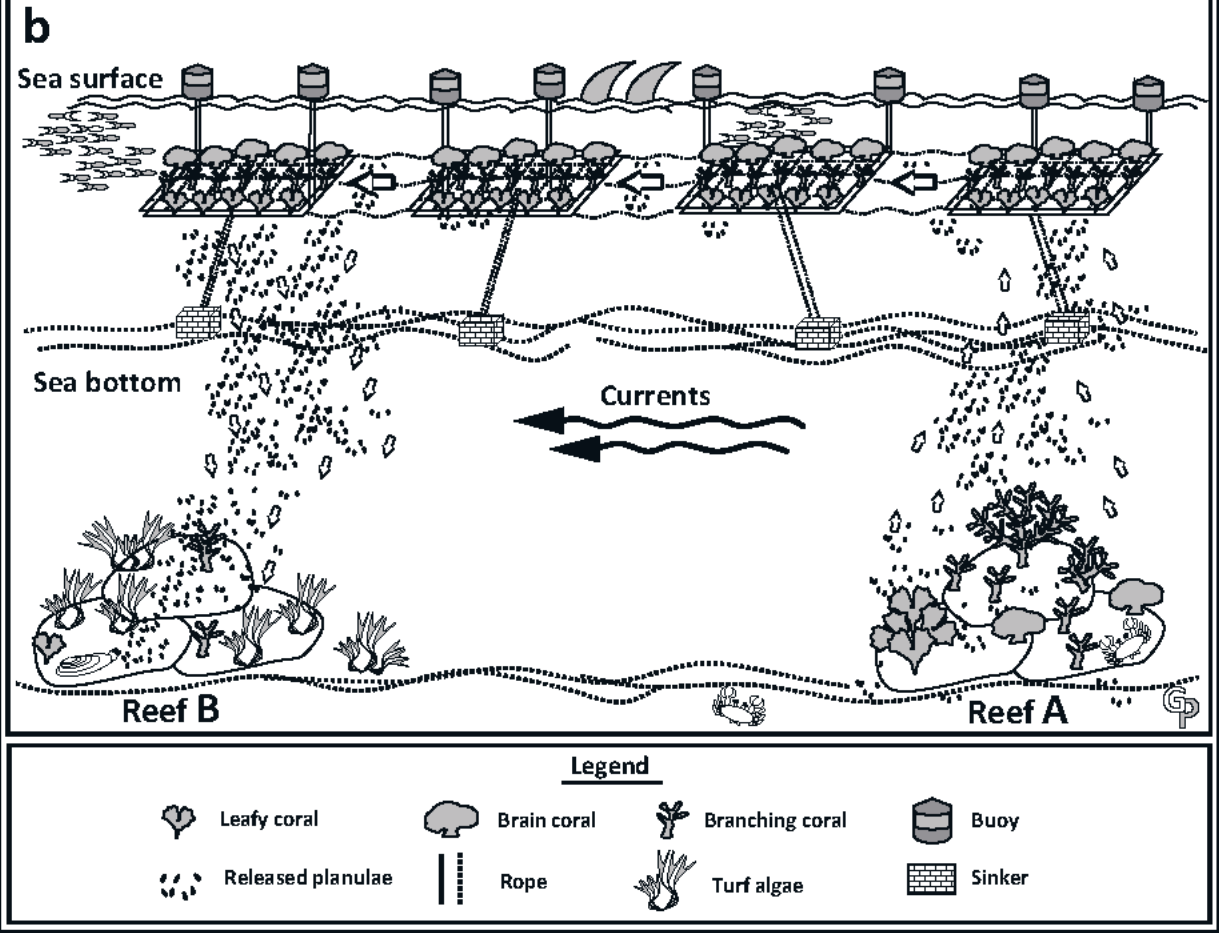
Figure 2. Schematic illustrations of two ecological engineering approaches to reef restoration, using the “gardening” tenet. ( a ) Employing coral nurseries as sexual reproduction hubs for the creation of masses of coral larvae, with the aim of enhancing larval seeding and recruitment in degrading reefs or in reefs that suffer from reduced recruitment (the reef at the left); ( b ) The establishment of new biological connectivity routes for coral reefs’ larvae. As a result of either reef degradation or changes in the current directionality, caused by global change/anthropogenic activities, the two reefs (right and left in the scheme) are no longer connected to each other via propagules. The establishment of stepping stones between both reefs, using floating mid-water nurseries, enables the reconstruction of biological connectivity between these two separated reef zones. Current literature provides additional ecological engineering approaches using sexual recruits, such as the tactic called “coral plug-ins” [60], where ex situ settled and raised spats are designed in a way that simplify their transplantation to degraded reef